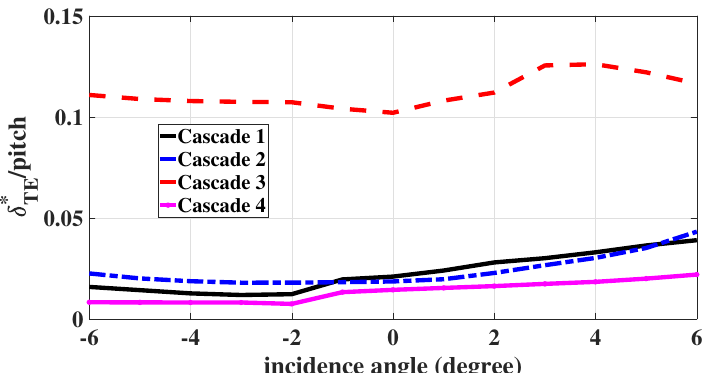
Figure 4. Trailing edge boundary layer displacement to pitch ratio for the 4 cascades from bladed CFD.